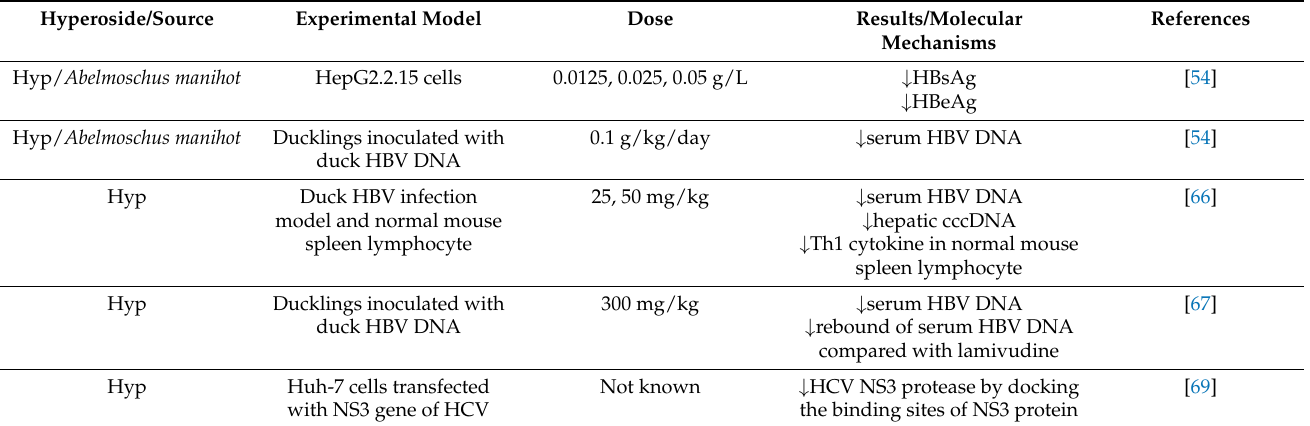
Table 2. Antiviral activities of hyperoside (Hyp) in experimental models related to hepatitis B virus (HBV) and hepatitis C virus (HCV)